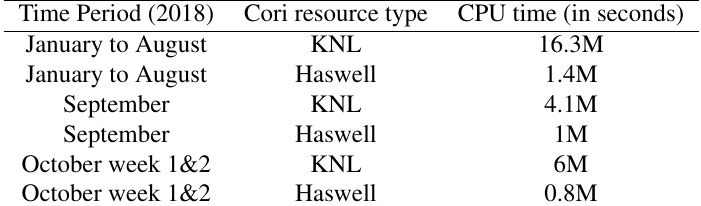
Table 1. Aggregate CPU time for Cori KNL and Haswell in CMS